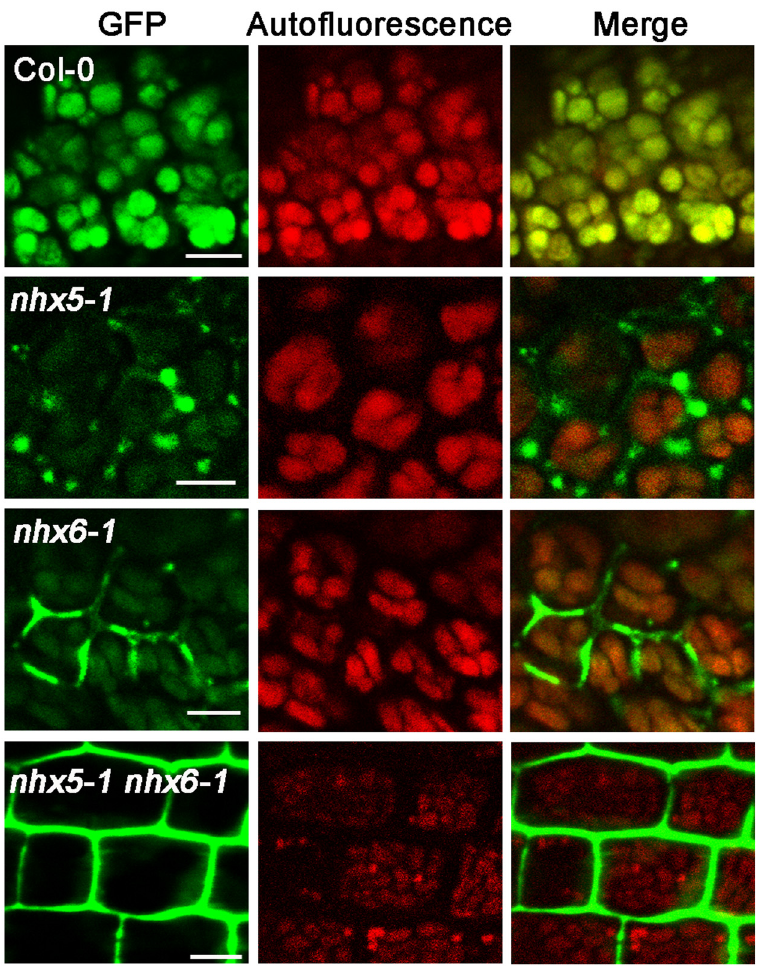
embryos of the mature seeds. GFP-CT24 was expressed in Arabidopsis seedlings and GFP-CT24 fluorescent signal was visualized with a confocal laser scanning microscope. Bars = 10 μ